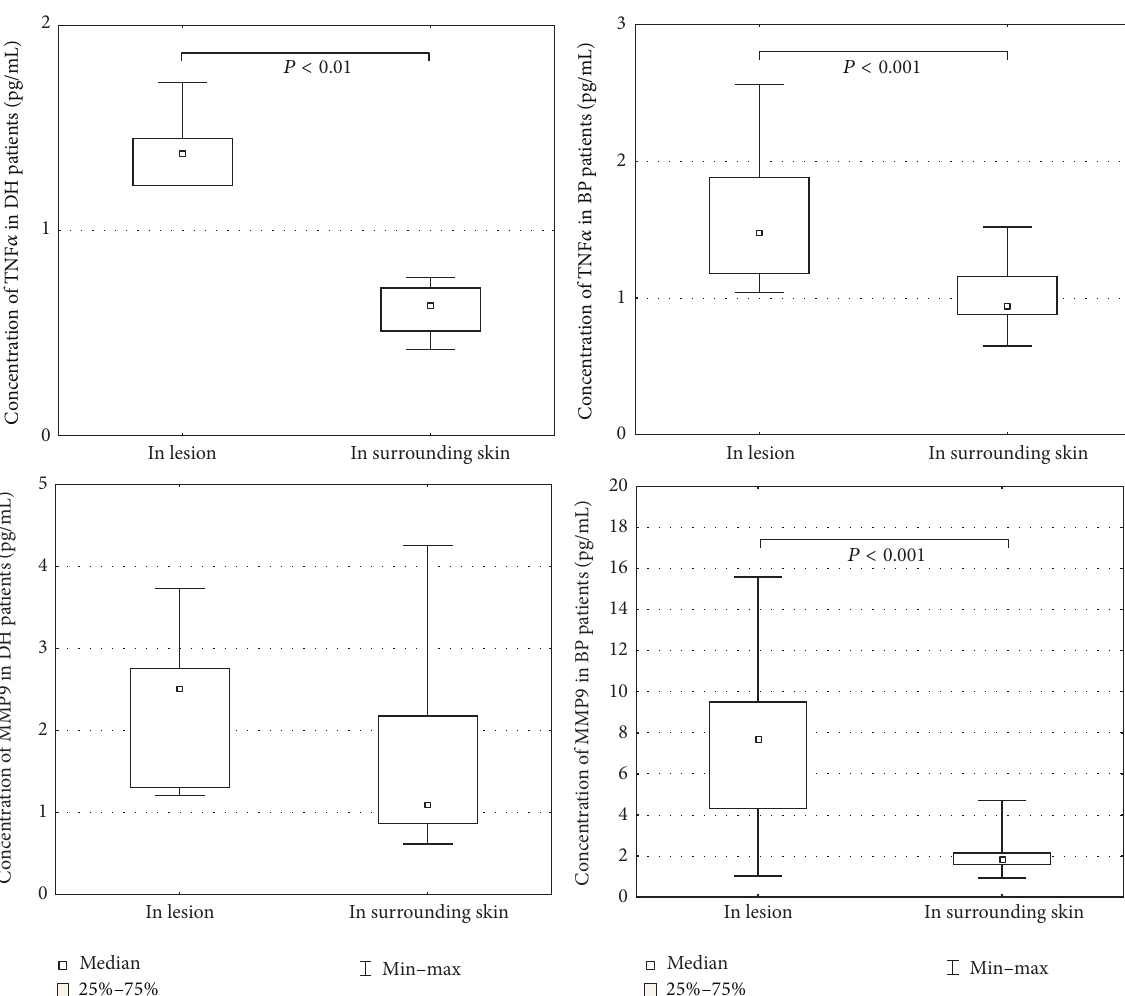
Figure 4: Morphometry of the immunoexpression of MMP9 and TNF 𝛼 , perilesional